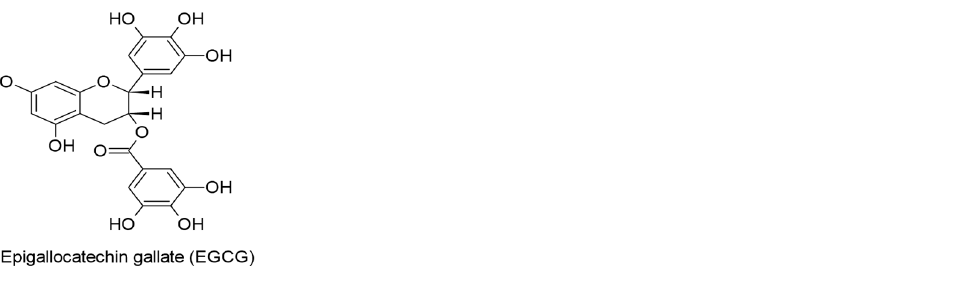
Figure 13. Chemical structures of (-)-Epigallocatechin gallate with therapeutic action against KSHV- positive primary effusion lymphoma (PEL) cells.